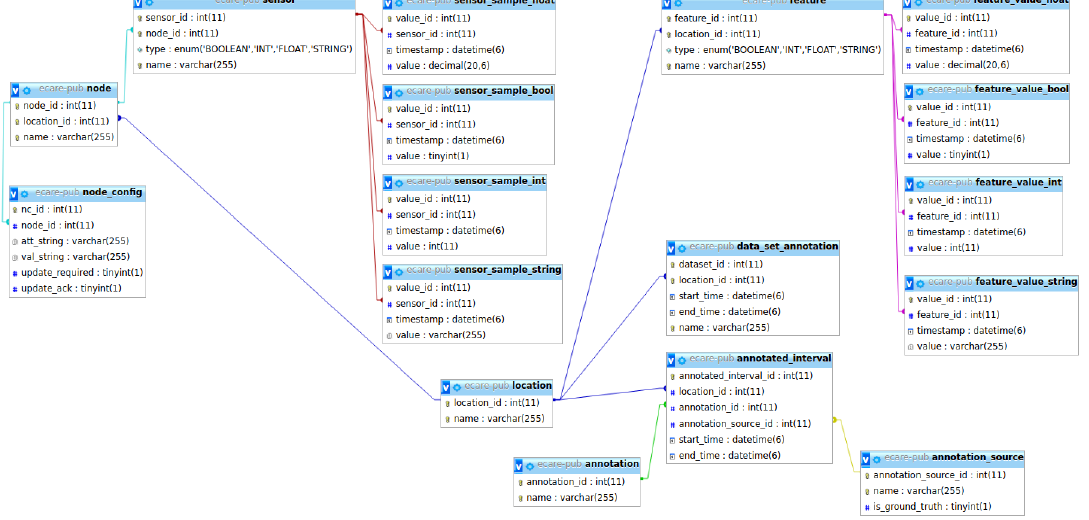
Figure 3. Table diagram of the E-care